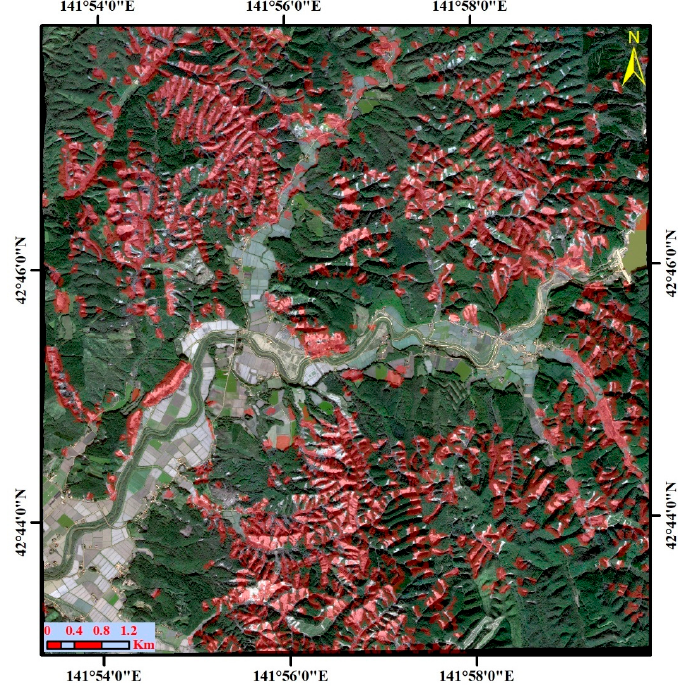
Figure 13. The landslide classification map using intensity differences from both the descending and the ascending SAR images (case 5). The background is a GeoEye-1 image taken on 20 October 2018.